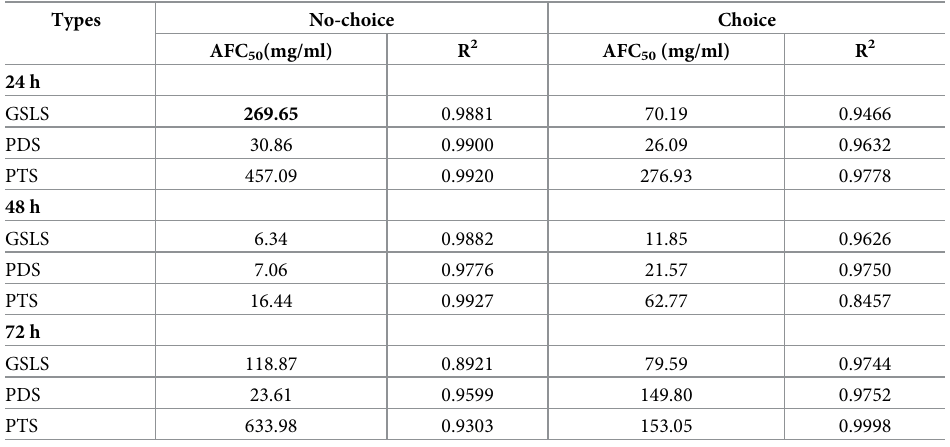
Table 3. Regression analysis for antifeedant activity of